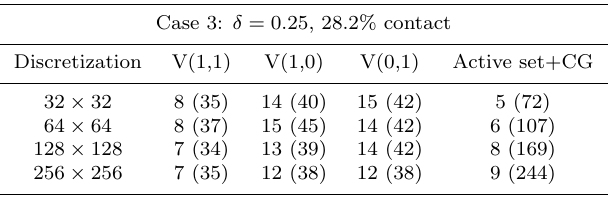
Table 7. Rough contact Case 3: the total number of active set iterations by FMG and the original method, with the numbers of work units in brackets.